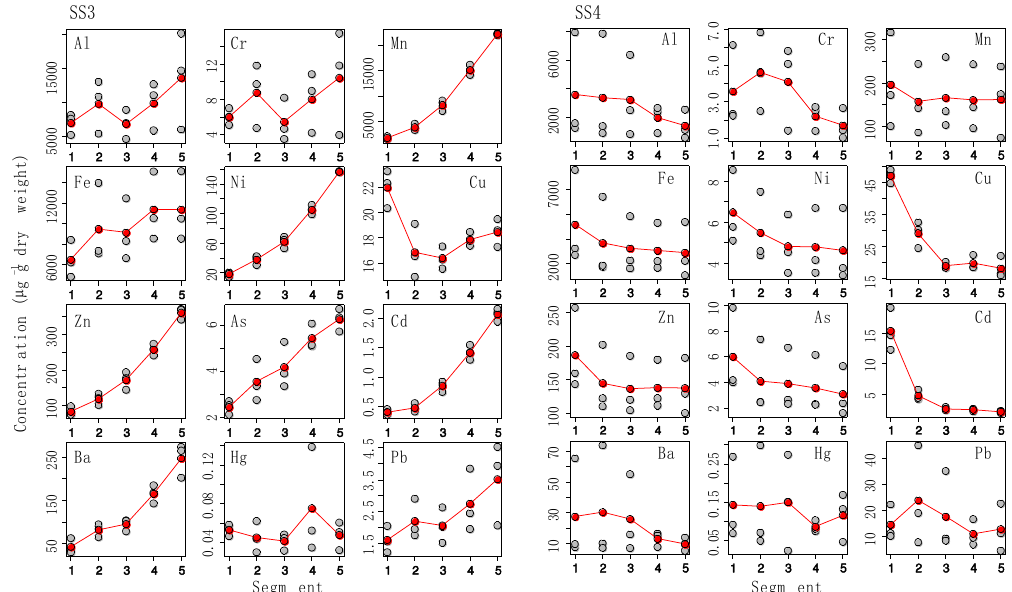
Figure 3. Element concentrations per dry weight in the shoot segments of each SS. Segments are numbered from 1 to 5, starting at the shoot tip. The red symbols are the means of the three replicates. We suspected that these differences could be caused by the underlying trend in dry weight ratios. To verify this, we calculated the fresh weight element concentrations, which are shown in Figure 4. The descending trends turned into increasing ones in most cases, only the trend for Cd in SS4 remained as descending. We estimated the significance of these trends by calculating Kendall’s τ correlation coefficient for each combination SS/element and testing them against τ = 0 (Table S1). The correlations were significant and positive for all elements in SS1–SS3, except for Hg in SS1, and for Mn, Ni, Zn, Cd and As in SS4.